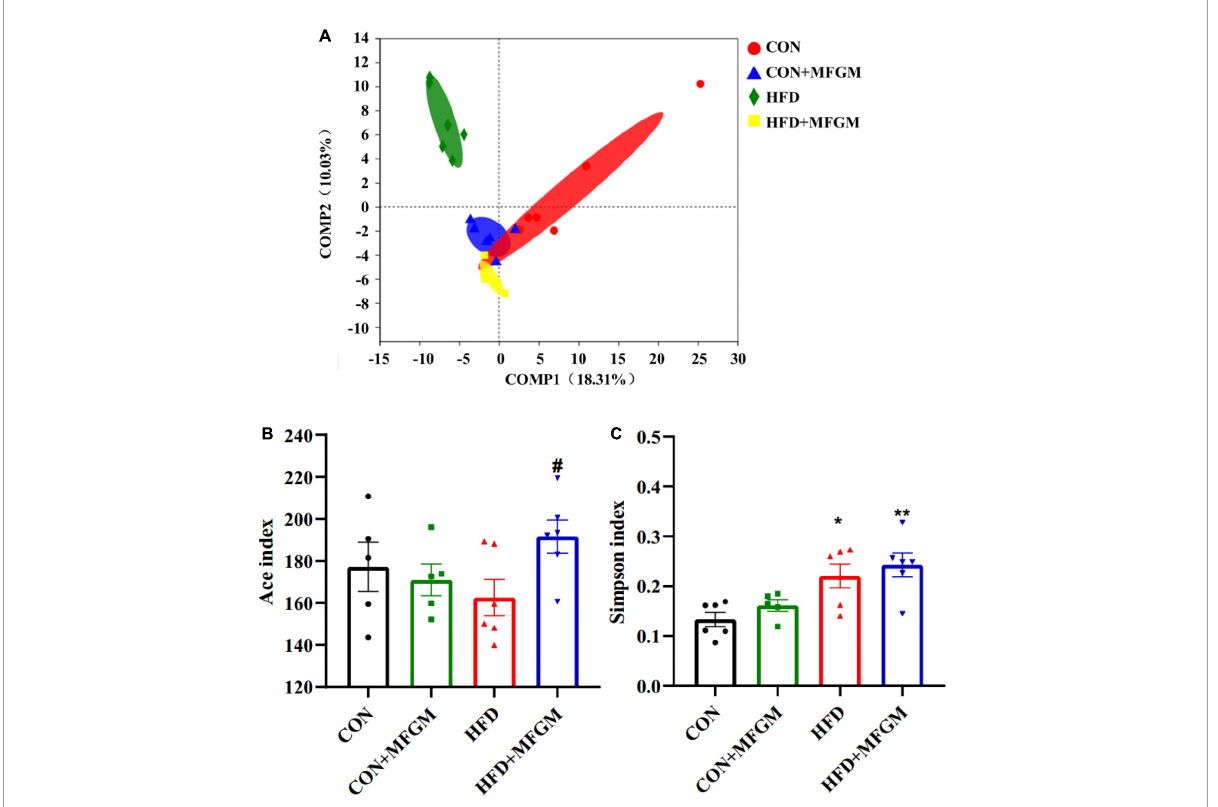
FIGURE3 Maternal supplementation with milk fat globule membrane during pregnancy and lactation modulated the overall structure of gut microbiota in weaned offspring from HFD dams. (A) Principal component analysis plot of the gut microbiota at the OTU level. The α -diversity of gut microbiota depicted according to Ace index (B) and Simpson index (C) at the OTU level. Values are mean ± SEM, n = 5–6. * P < 0.05 vs. CON group. # P < 0.05 vs. HFD group. ## P < 0.01 vs. HFD